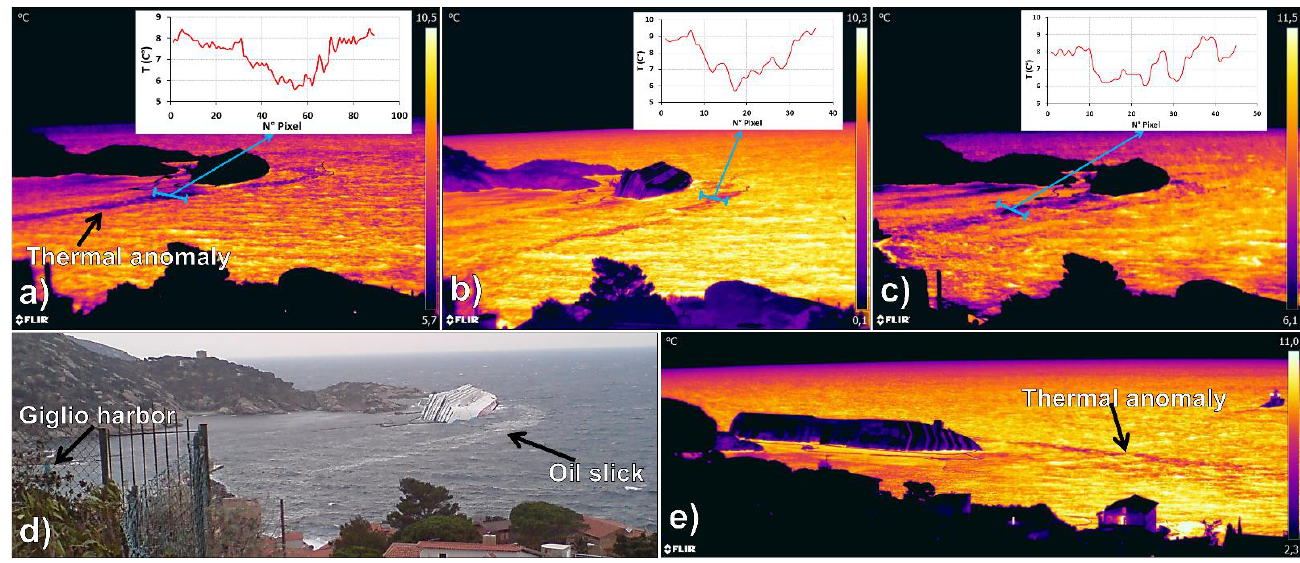
Figure 4. IRT applied for oil slick detection during the defueling operations (colorbar “iron”). Thermograms acquired from P3 on 3 February 2012 at 00:40 ( a ) and 12:30 ( b ); thermogram acquired from P3 on 4 February 2012 at 00:00 ( c ); correspondent optical image of b ( d ); mosaicked thermogram acquired from P2 on 3 February 2012 at 00:40 ( e ).